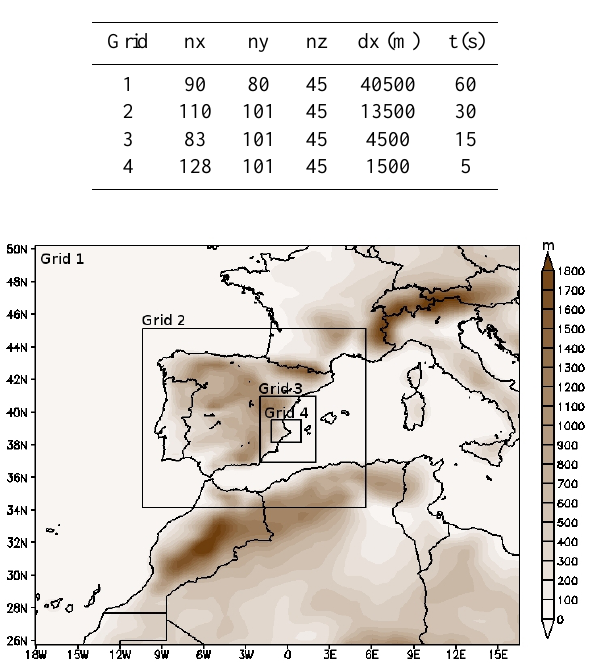
Fig. 7. RAMS model domains and orography (m) and long-wave radiation, is used in RAMS model. The cu- mulus parameterization schemes implemented in model ver- sion 6.0 are the Kuo and the Kain-Fritsch. In our simula- tions, they are activated or not in a set of combinations of the model grids. The cloud and precipitation microphysics scheme from Walko et al. (1995) has been applied in all the domains. The rain event took place from the last hours of 11 October to the first half of 12 October; thus, we have run our simulations during 48 h, starting at 00:00 UTC on the 11th of October 2007 and finishing at 00:00 UTC on 13 October. To determine whether activating the Kuo and KF schemes in different grid resolutions affects/improves precipitation forecasting, a series of numerical simulations have been per- formed. Cumulus parameterization schemes have been ac- tivated/deactivated in the model grids for a set of numerical experiments, yielding a total of eight different simulations (Table 3). Although model Grid 4 has enough high spatial resolution to explicitly resolve convection and no parameter- ization is needed, we have run a experiment with the Kuo scheme activated in inner Grid 4; the experiment with the KF scheme active in Grid 4 did not succesfully finish. An additional experiment has been run without any CP active in any of the model grids (NoC).